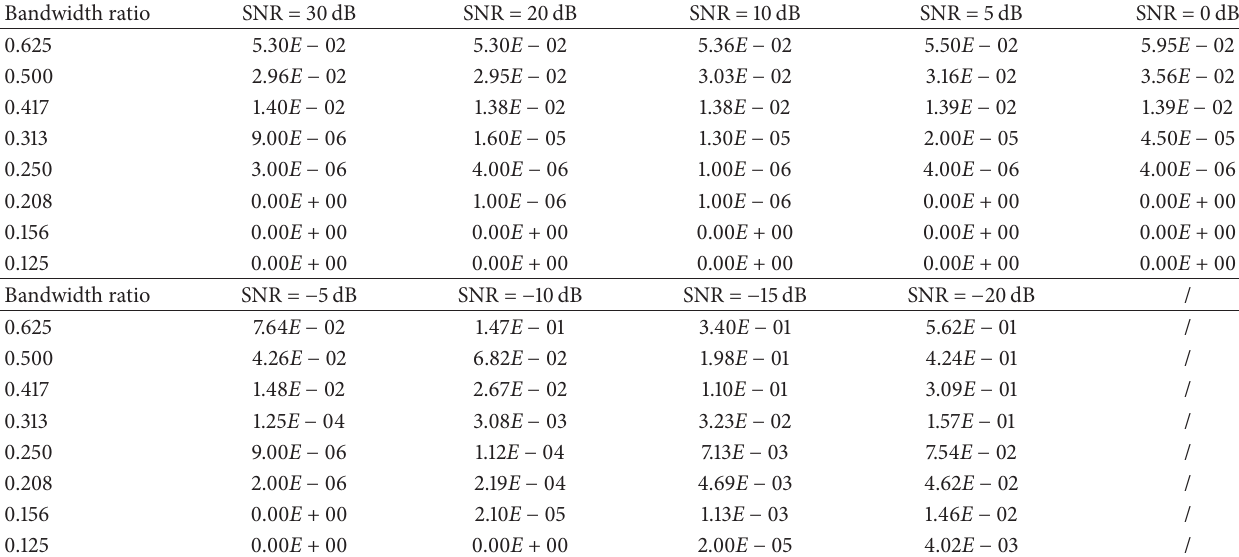
Table 1: The BER of the simulation system with the optimum T-F mask.